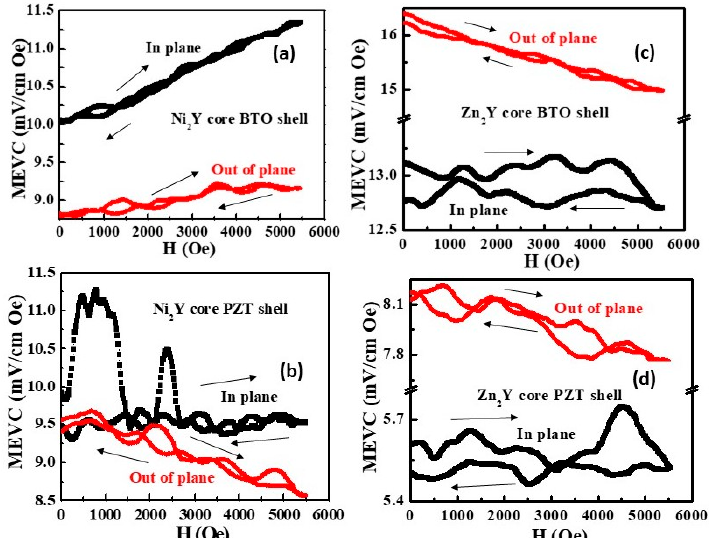
Figure 11. The room-temperature magneto-electric voltage coefficient (MEVC) as a function of applied field H for 3D films of ferrite cores and ferroelectric shells. Data are for H and h ac parallel to each other and either parallel or perpendicular to films of ( a ) Ni 2 Y–BTO, ( b ) Ni 2 Y–PZT, ( c ) Zn 2 Y–BTO, and ( d ) Zn 2 Y–PZT. The fibers with BTO were annealed at 1200 °C and assembled into a 3D film in a magnetic field. Fibers with PZT were annealed at 1000 °C. Arrows indicate data for increasing and decreasing H.